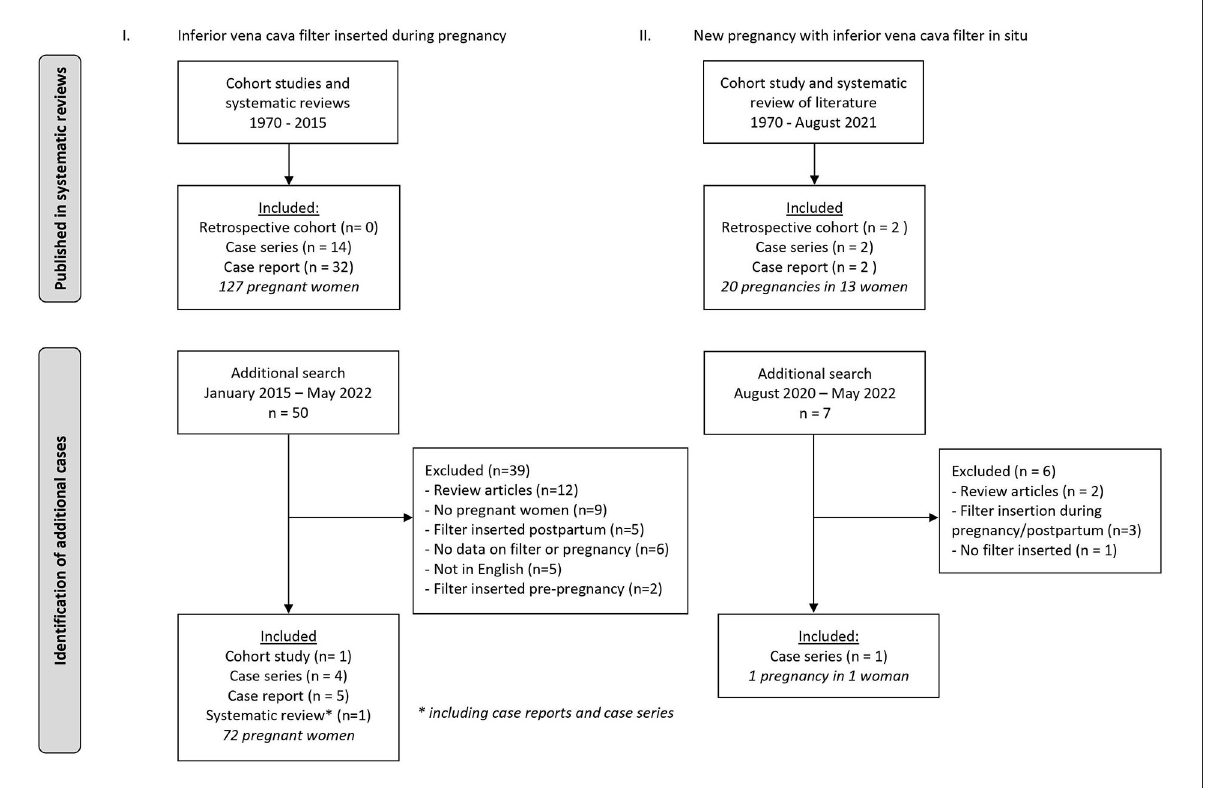
FIGURE1 Flow chart literature